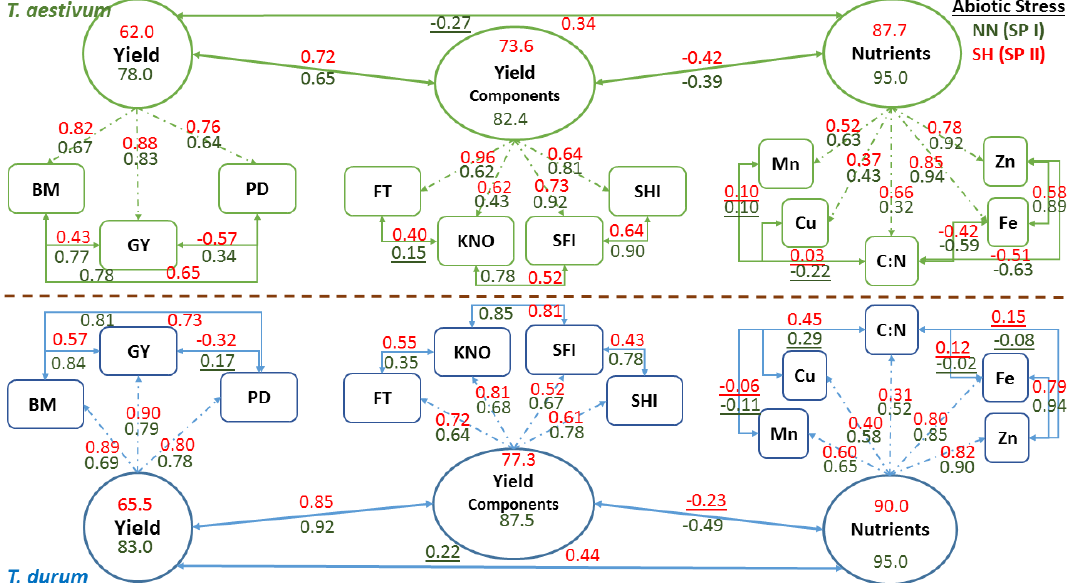
Figure 6. Schematic representation of confirmatory factor analysis based on path coefficients (arrows with single heads) relating latent variables (oval shapes: nutrients, yield components and yield) with observed variables (rectangles), correlation coefficients between observed variables, and variance in latent variables explained by observed variables in two wheat genotypes representing T. durum and T. aestivum at the end of stress phase II (SH-SP II) under maximum abiotic stress (SH, short growing season and high population density) compared to the control at the end of stress Phase I (NN, normal length of growing season and normal population density; NN-SP I). Underlined values are not significant; Tukey’s HSD, p > 0.05). [PP estimates of GCP were excluded from the analysis due to collinearity with C:N ( r = − 0.98; p < 0.0001)].